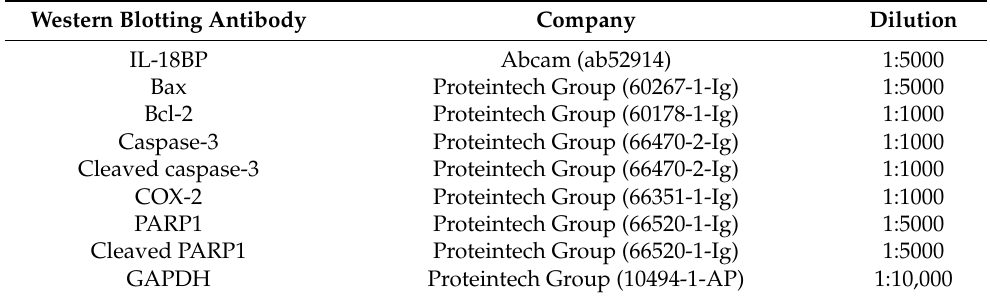
Table 2. Antibodies used in Western